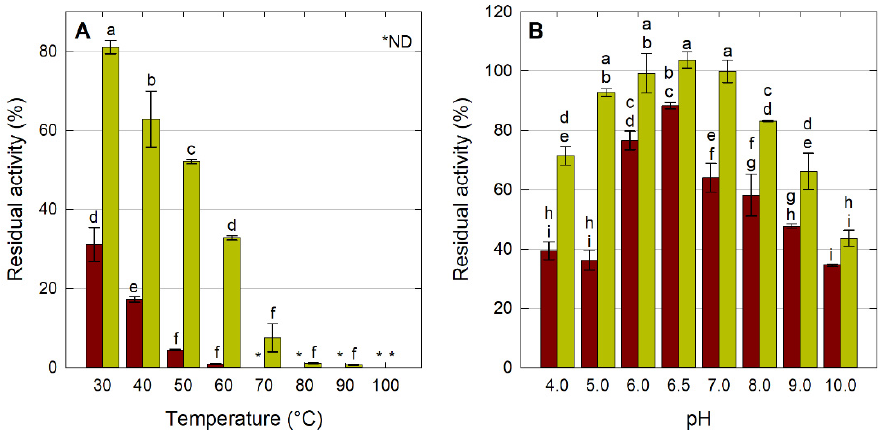
Figure 4. Characterization of LipMatCCR11-CLEAs. Effect of temperature ( A ) and pH ( B ) on lipolytic stability. All values are the mean of three replicates. Red: LipMatCCR1, Green: LipMatCCR11-CLEAs. Error bars represent the standard deviation within the data set. Different lowercase letters indicate significant differences according to Tukey's multiple comparison tests ( p < 0.05). The 100% value corresponds to a CLEA activity of 7755 ± 144 U/g. *: Non-detectable.